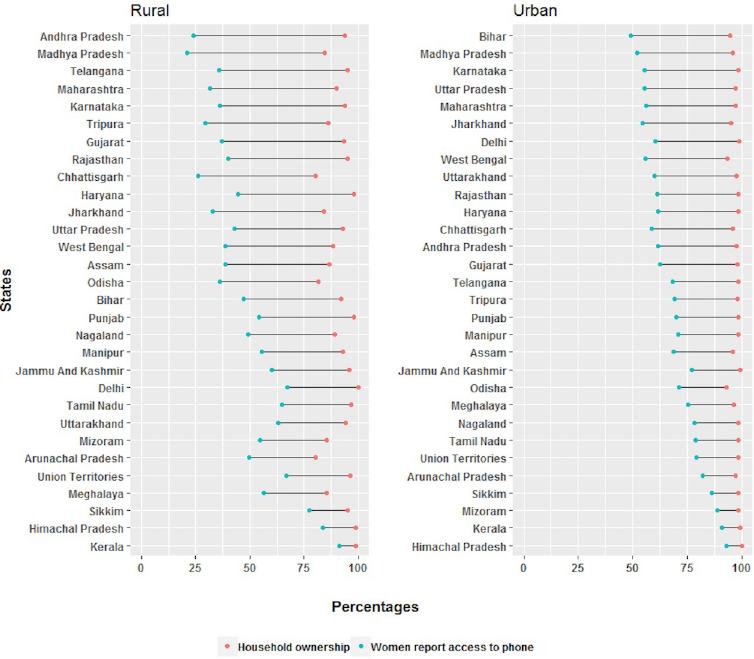
Fig 3. Differentials in rural and urban household ownership of mobile phones and women’s reported access by state. States are listed by the descending order of the gap between household ownership and women’s access.